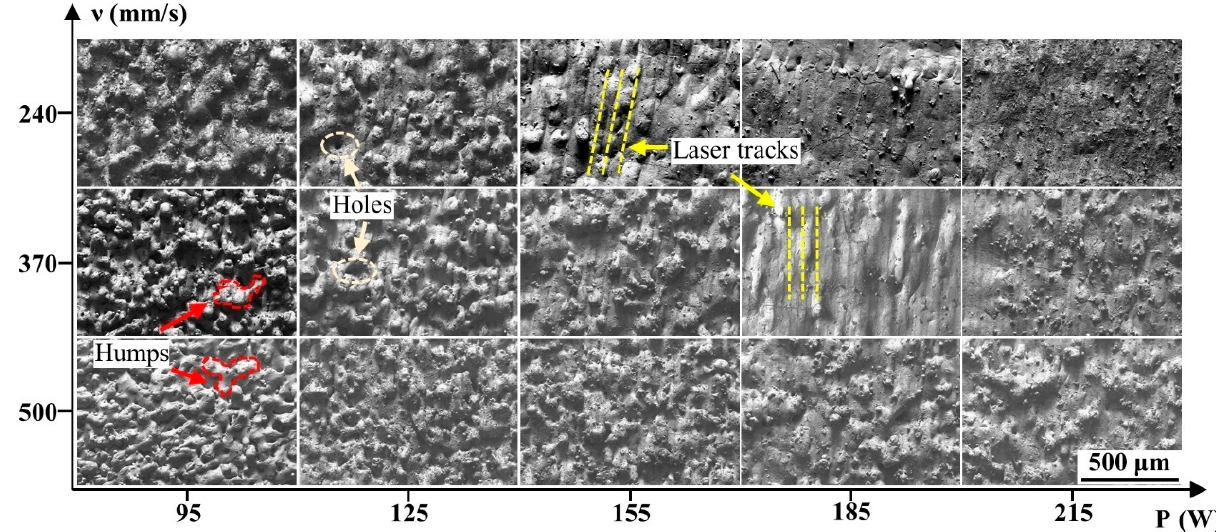
Figure 3. The top surface morphology of the cemented carbide parts formed under the Scan I strategy.